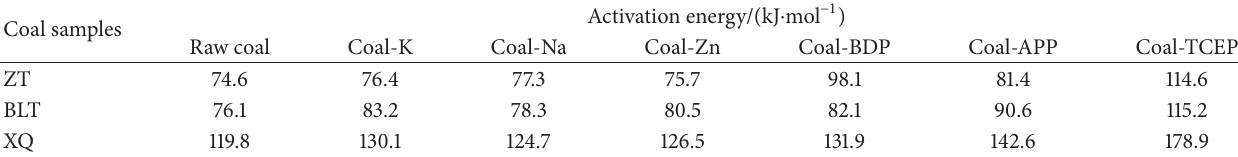
Table 3: Activation energy of the coal samples before and after